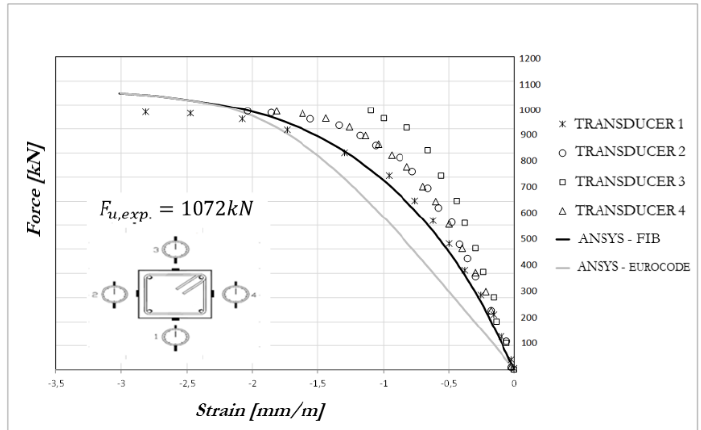
Figure 8. Comparison of Column 1 results.